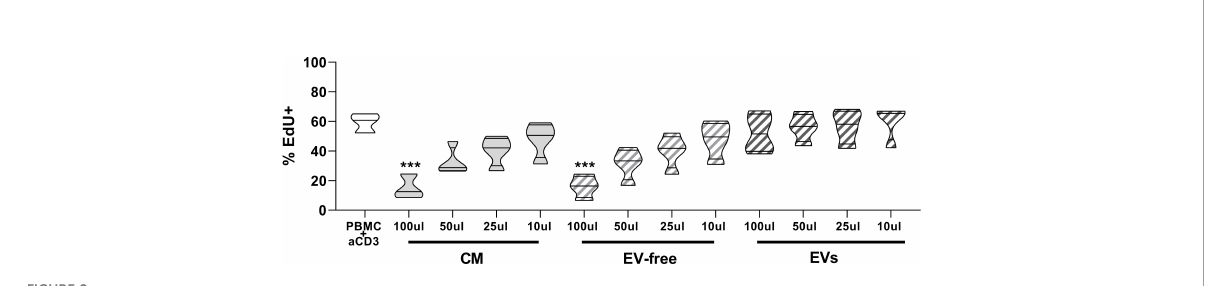
FIGURE 2 Effects of hAMSC-CM and its fractions (EV-free and EVs) on PBMC proliferation. Allogeneic PBMC (1×10 5 ) were stimulated with anti-CD3 antibody in the presence of 100, 50, 25, or 10 µl of hAMSC-CM in toto or with the same volume of the EV-free or EV fractions. Results are expressed as percentage of EdU+ cells representative of the proliferating cells. PBMCs stimulated with anti-CD3 mAb constitute the positive control. Results are displayed as violin plots showing median (thick line) and 25th and 75th quartiles (*** p <0.001 versus control (PBMC+anti- CD3), N ≥ 3.